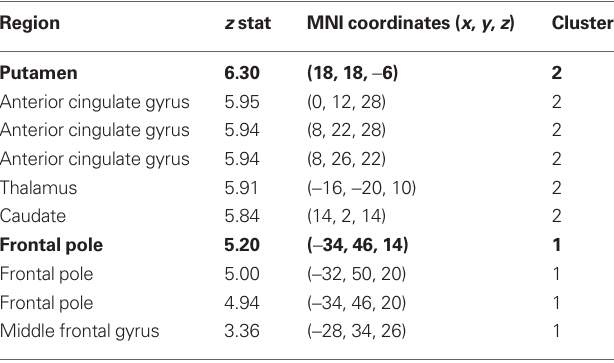
Repeated-measures 2 × 2 ANOVA of reward anticipation. The table here corresponds to the statistical map presented in Figure 3 . Cluster maxima are listed in bold. All coordinates listed are in MNI